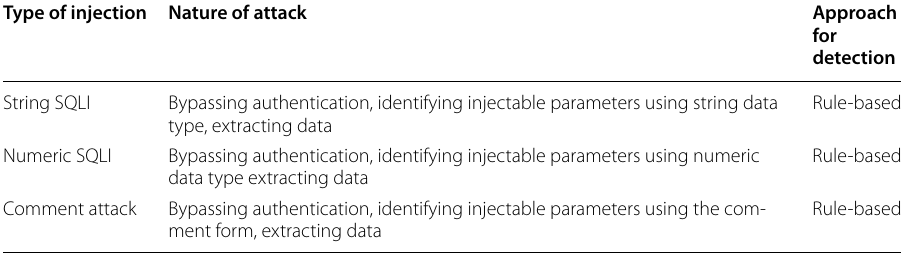
Table 1 Common tautology attacks [54] Type of injection Nature of attack